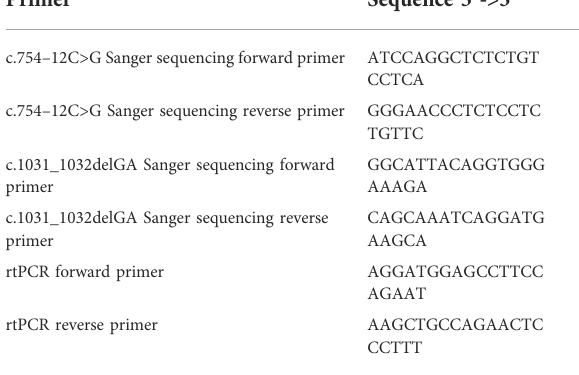
TABLE 1 Primers of Sanger sequencing and reverse transcription PCR (rtPCR).